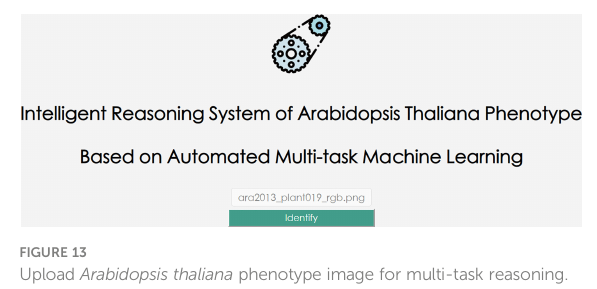
FIGURE 14 Illustration of Arabidopsis thaliana phenotype multi-task reasoning